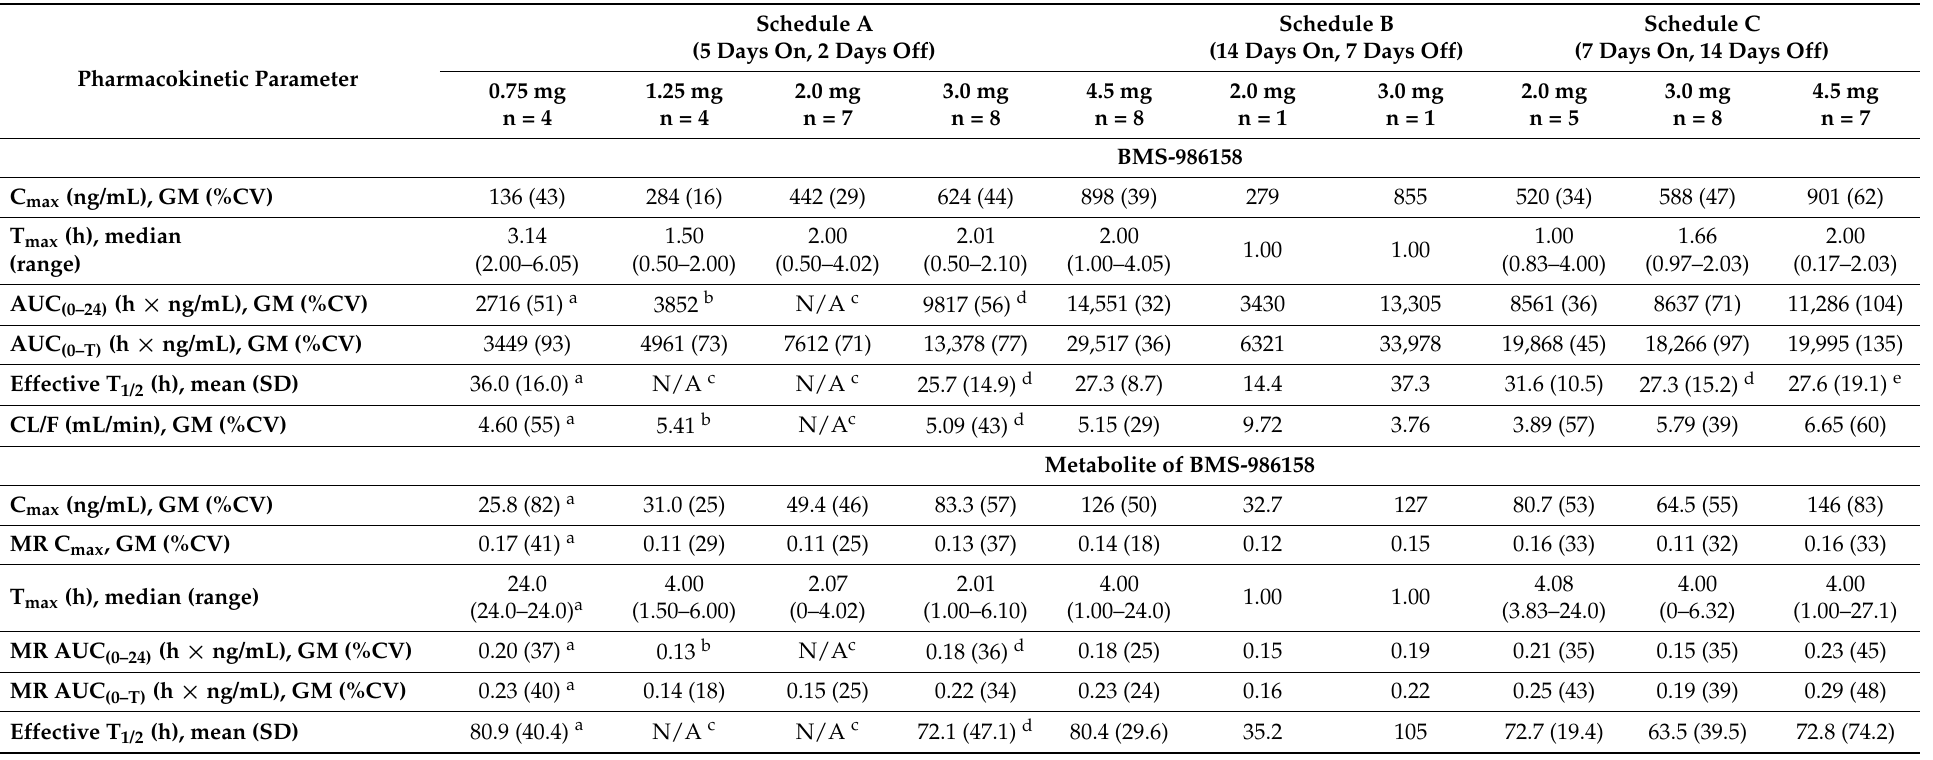
Table 3. Pharmacokinetics of BMS-986158 and its metabolite at steady state after multiple-dose treatment